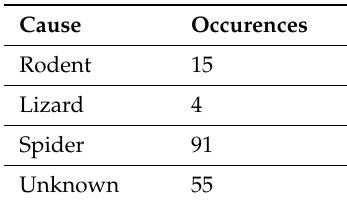
Table 5. Sensors used in the Ratspy